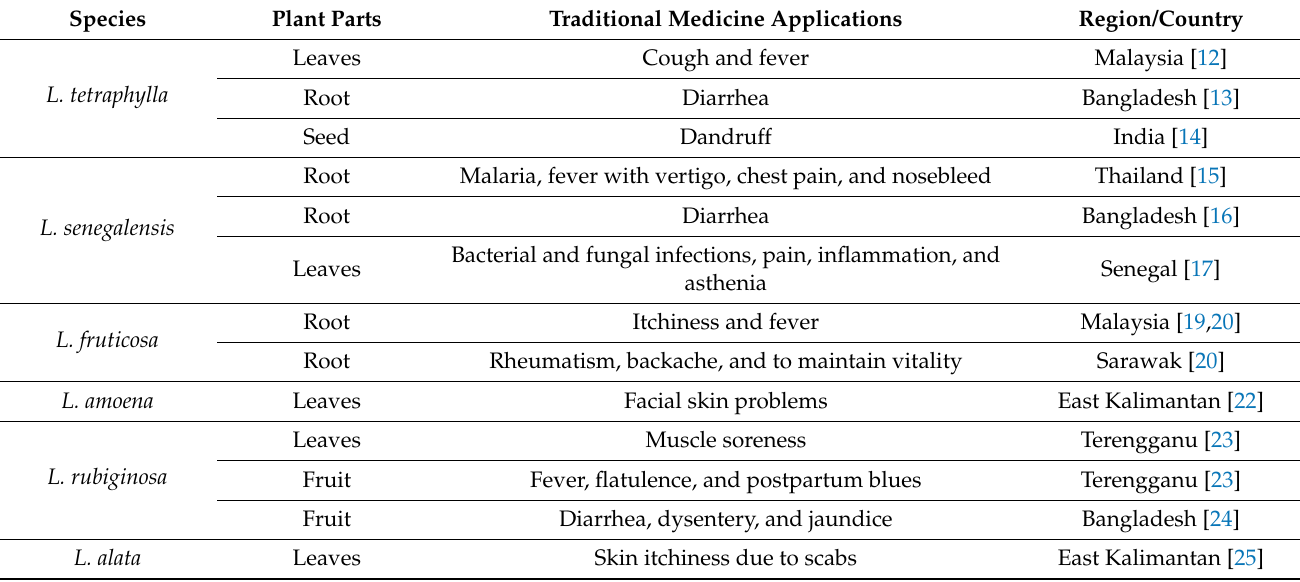
Table 1. Summary of traditional uses of the genus Lepisanthes